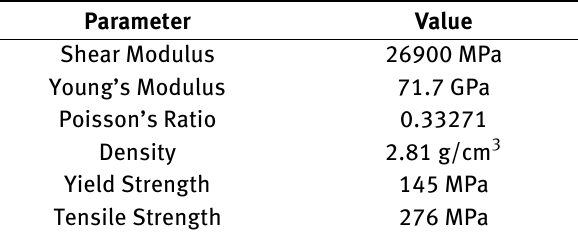
Table 7: Properties of the material Aluminum 7075